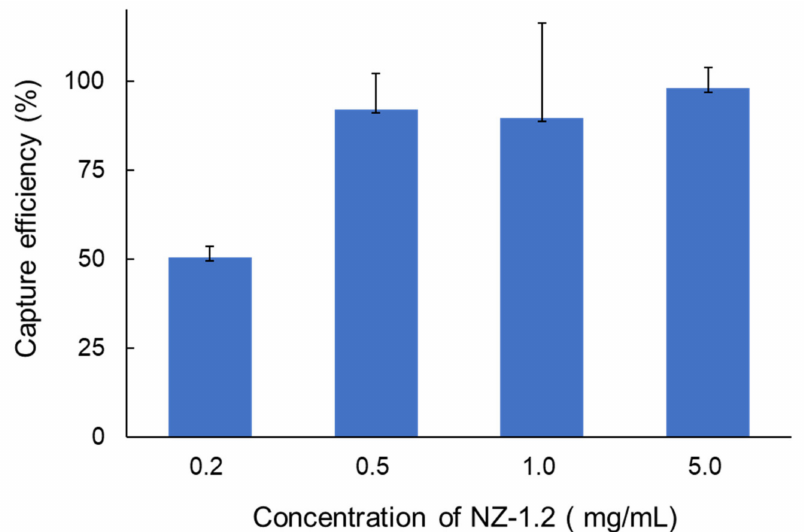
Figure 2. Cell-capture e ffi ciency of the CTC-chip coated with an anti-podoplanin antibody (NZ-1.2) at various concentrations in capturing malignant pleural mesothelioma (MPM) cells